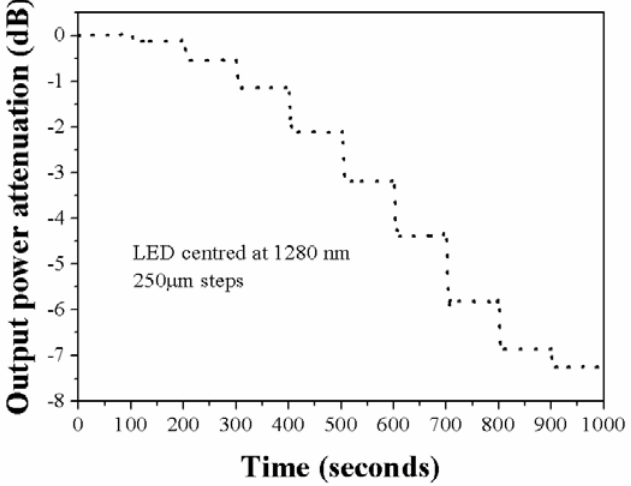
Figure 12. Time stability of the fiber loop displacement